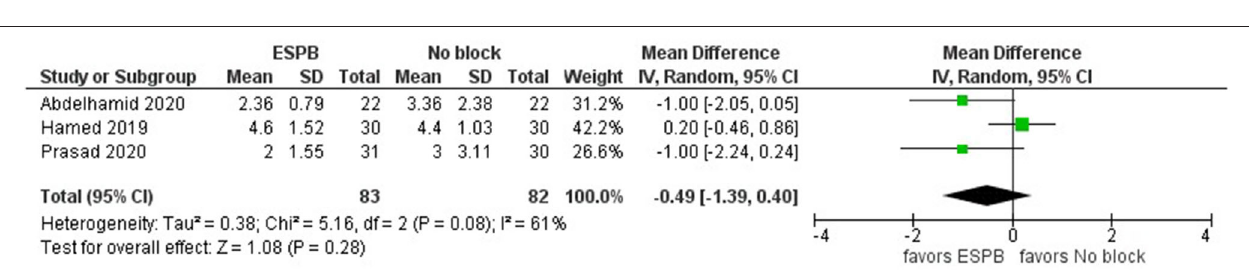
FIGURE 3 | Forest plot of pain intensity in the first 24h after surgery (in VAS